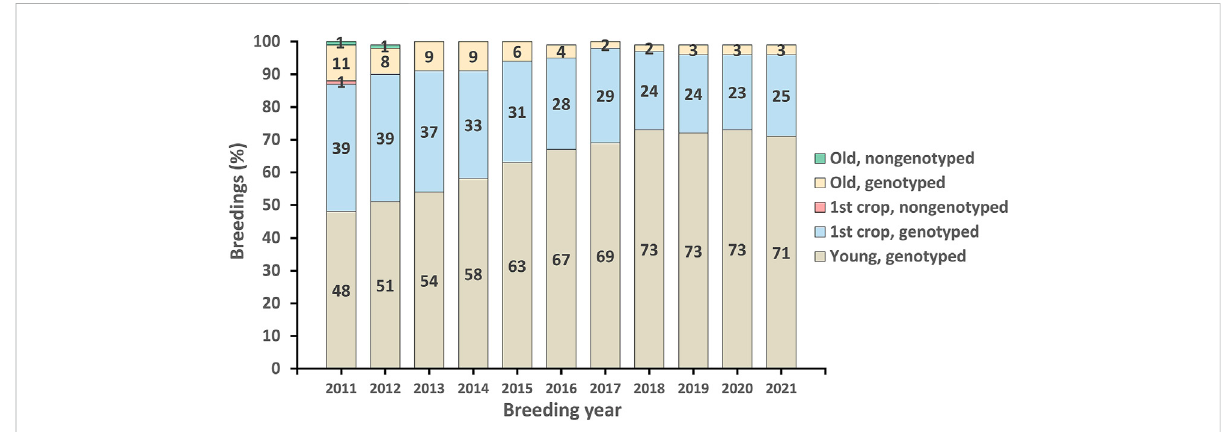
FIGURE 3 Genomic pro fi le of Holstein service sires used for arti fi cial-insemination breeding in the United States since 2011.